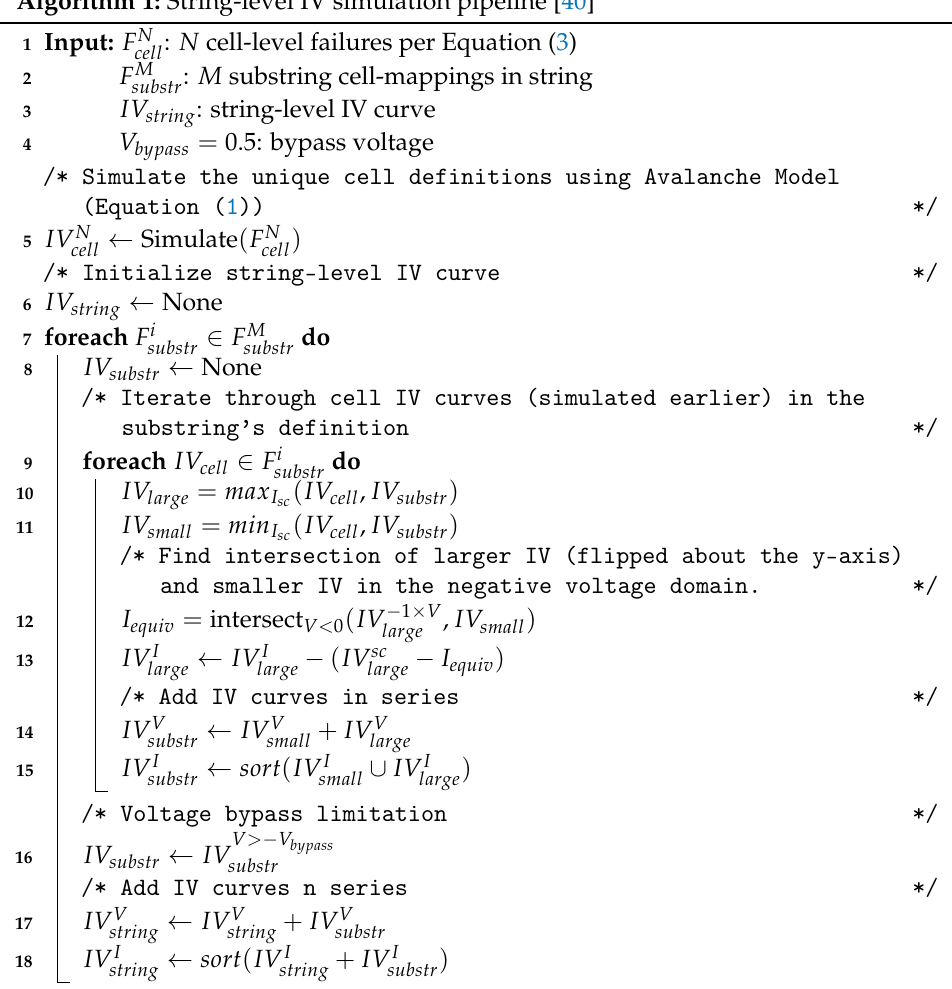
Algorithm 1: String-level IV simulation pipeline